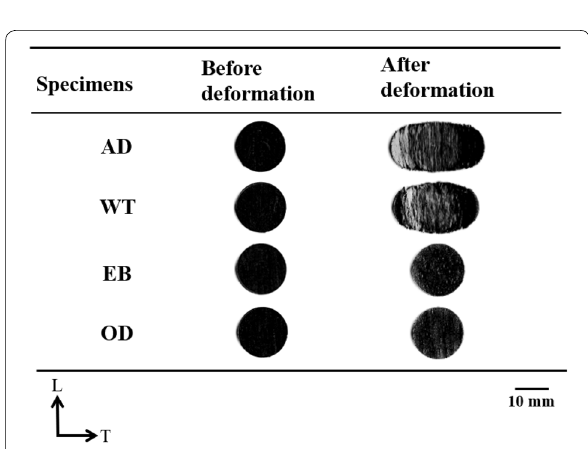
Fig. 6 Representative change in shapes of specimens before and after the free compression test